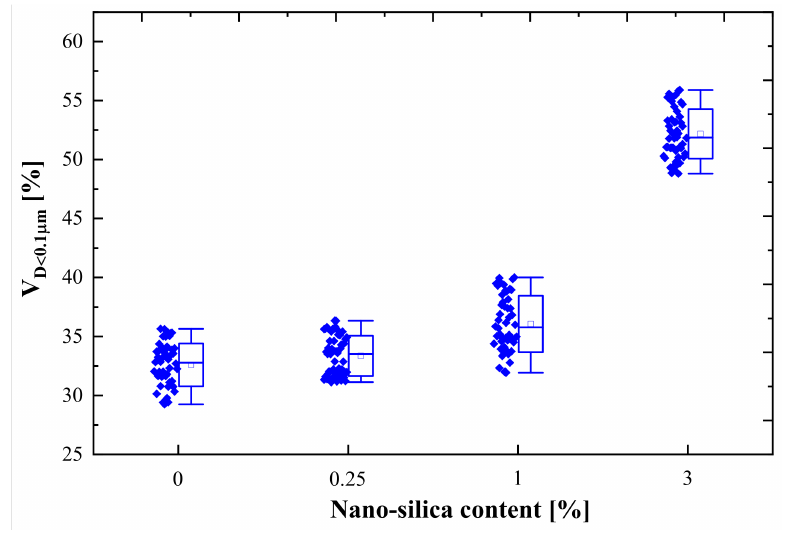
Figure 6. Determination of V D < 0.1 µ m of soil samples with various NS